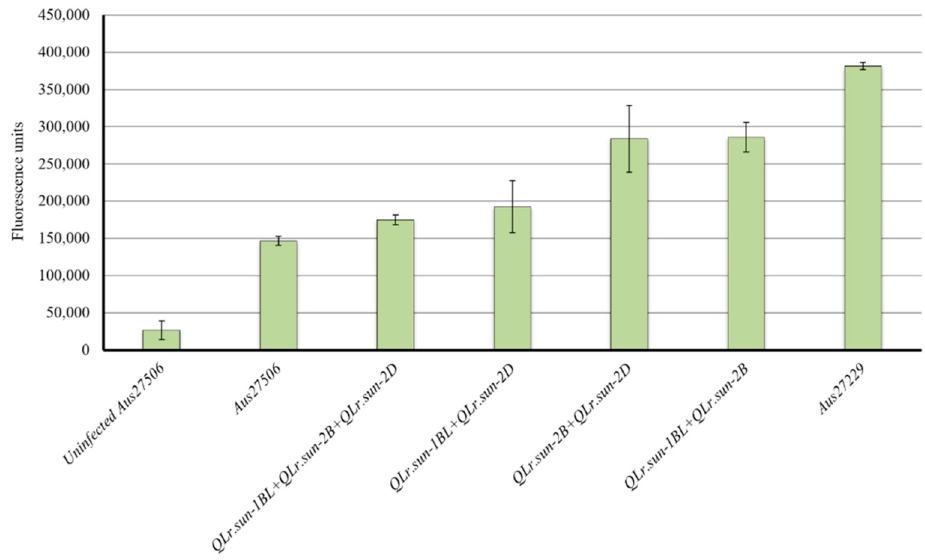
Figure 3. Quantification of rust growth in Aus27506, Aus27229 and RILs carrying different QTL combinations.